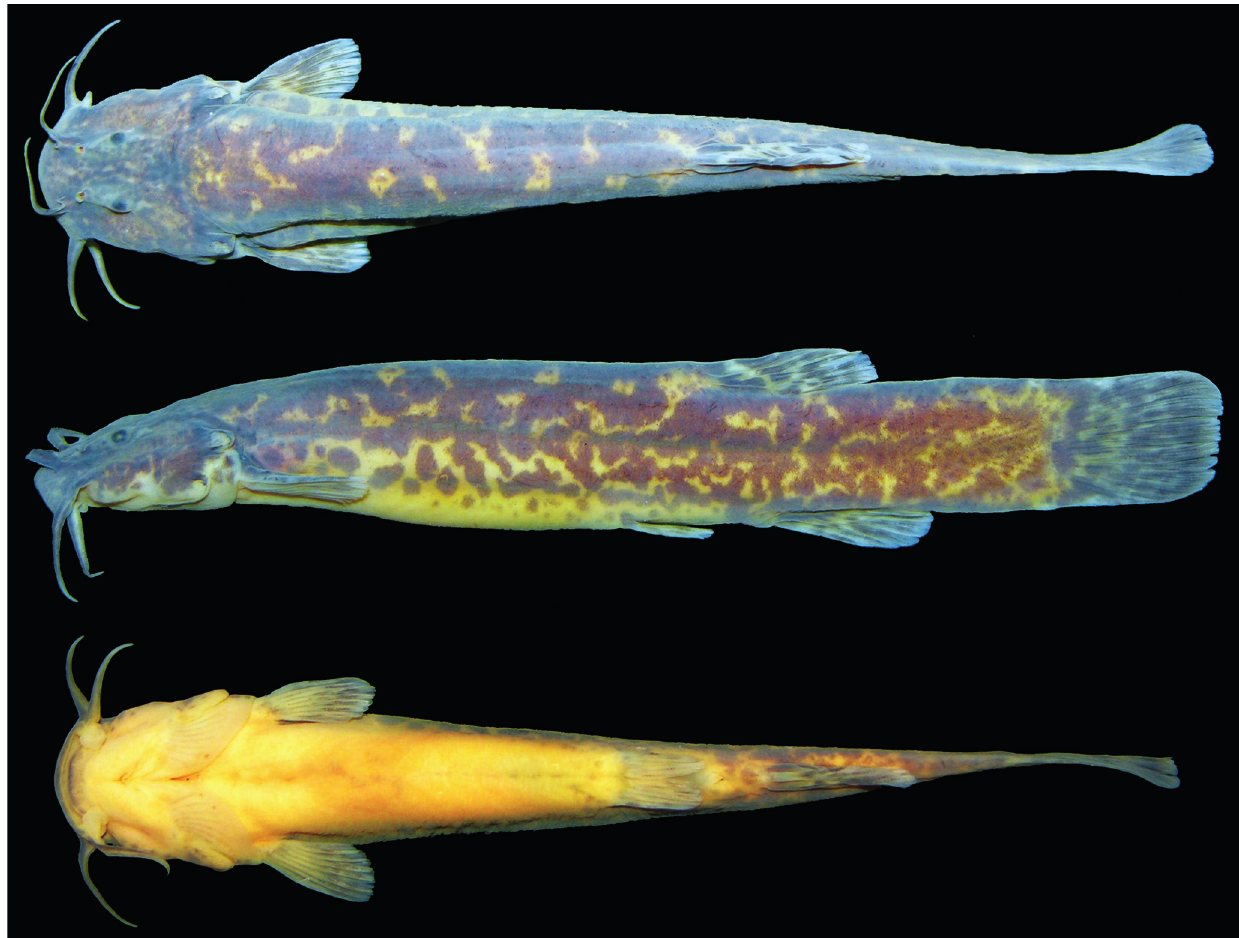
Fig. 10. Trichomycterus diatropoporos , holotype, MCP 46947, 58.8 mm SL, Brazil, Rio Grande do Sul State, municipality of Nova Prata, rio da Prata at Passo do